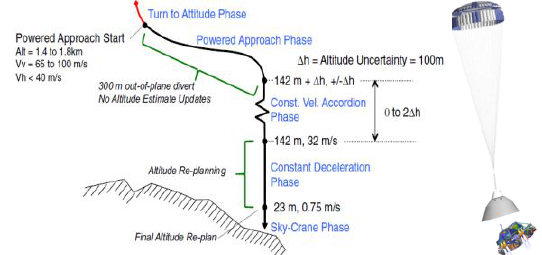
Figure 7. Divert maneuver of MSL (Martin et al., 2015)